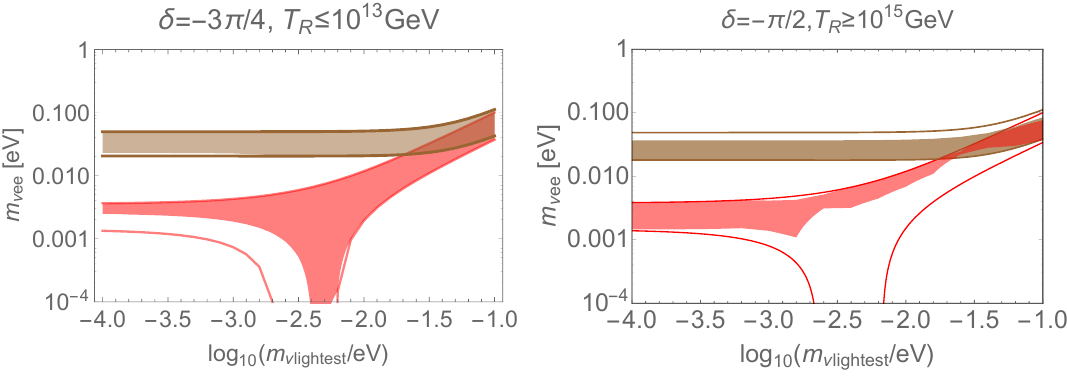
Figure 9 . The value of e(cid:11)ective neutrino Majorana mass, m (cid:23)ee , compatible with our scenario. The in(cid:13)aton decays into Higgs boson. T R . 10 13 GeV ; (cid:14) = (cid:0) 3 (cid:25)= 4 and T R & 10 15 GeV ; (cid:14) = (cid:0) (cid:25)= 2 are assumed for the left panel and right panel, respectively. The region between upper and lower black (brown) lines is the general possibility for normal (inverted) hierarchy while the shaded regions are our prediction.